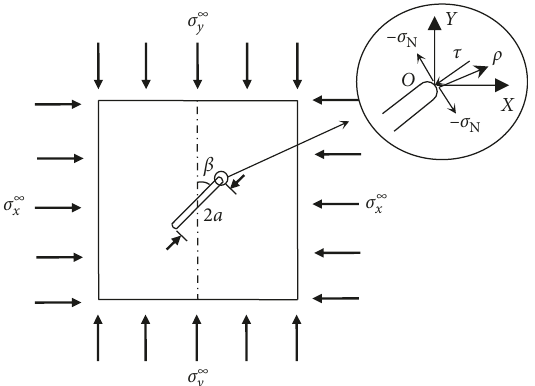
Figure 1: External and internal stresses for mixed mode I-II crack in infinite